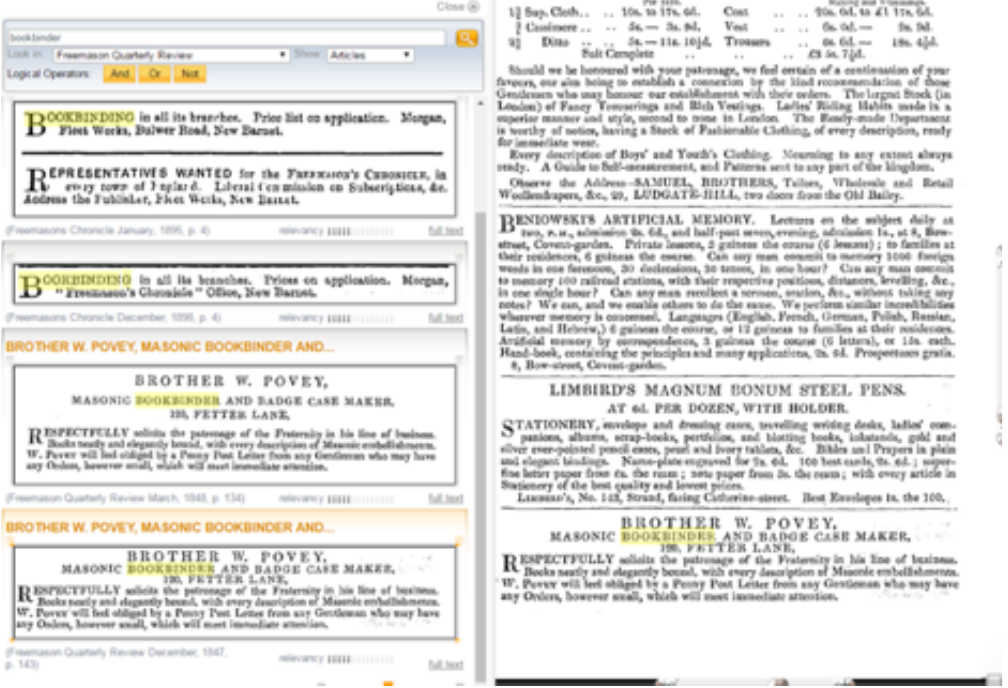
Fig. 48. Advertisements for Brother W. Povey, Masonic Bookbindings and Badge Case Maker from the Freemasons’ Quarterly Review . Screen shot of Masonic Periodicals site.